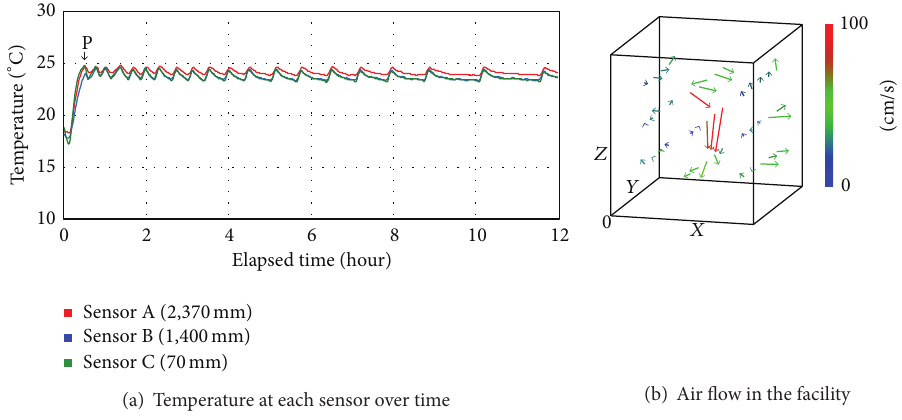
Figure 6: Temperature and air flow in the controlling condition of Case